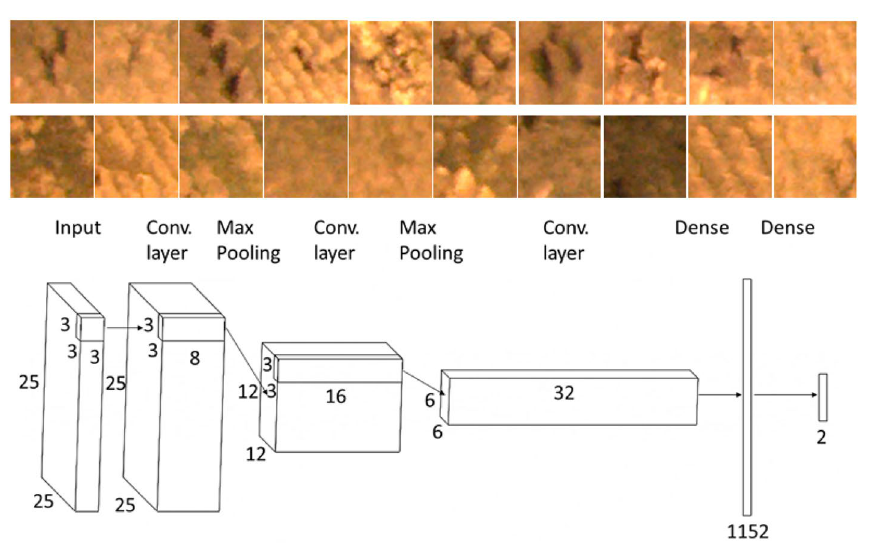
Figure 7. Examples of data for dots localization CNN training. Upper row – dots, bottom row – areas without